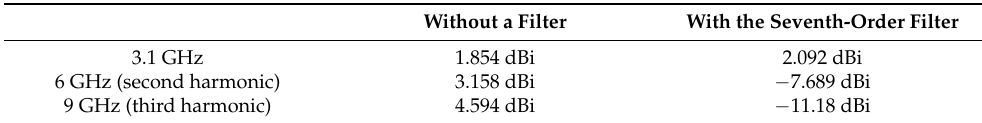
Table 4. Comparison of simulated maximum gain in the harmonic section of the antenna without a filter and the proposed antenna.